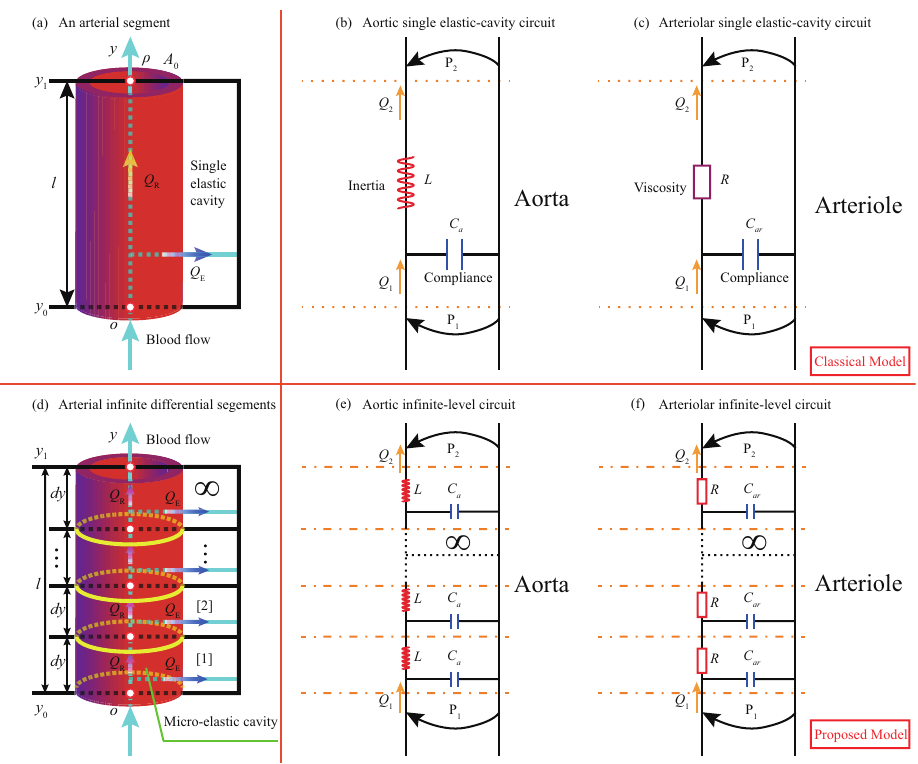
Figure 2. Aortic and arteriolar infinite-level elastic-cavity physic models expanded from the single one and their analogous circuits: ( a ) Physical structure of a single-level elastic cavity of an arterial vessel; ( b , c ) Analogous circuits of aortic and arteriolar single elastic cavity; ( d ) Physical structure of infinite micro-elastic cavities formed by micro-differentiation of a single elastic cavity; ( e , f ) Analogous circuits of infinite-level micro-elastic cavities of the aorta and